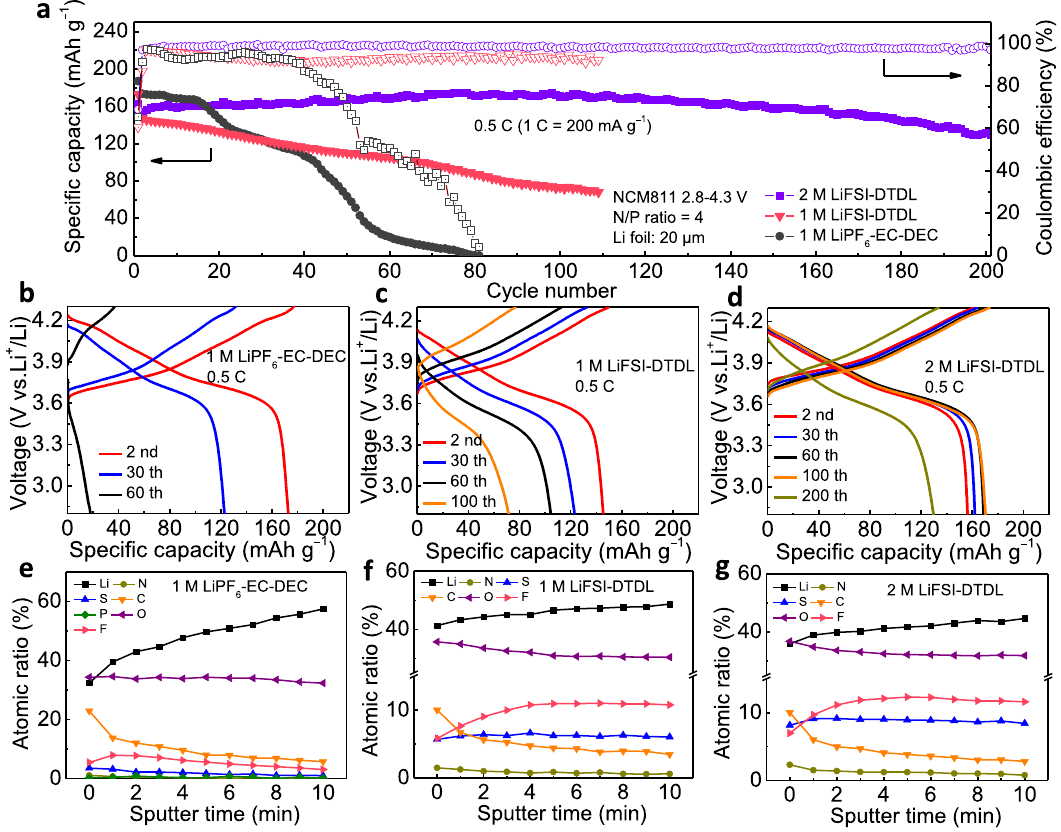
Fig. 4 Electrochemical performance and SEI compositions of Li|NCM811 full cells. a Cycling performance of Li|NCM811 full cells at 0.5 C after the fi rst formation cycle at 0.1 C in each electrolyte. Charge/discharge pro fi les of Li|NCM811 full cells at different cycles in 1 M LiPF 6 -EC-DEC ( b ), 1 M LiFSI-DTDL ( c ) and 2 M LiFSI-DTDL ( d ) electrolytes. Quanti fi ed atomic ratios of SEI at different sputter time in Li|NCM811 full cells after 30 cycles at 0.5 C with 1 M LiPF 6 -EC-DEC ( e ), 1 M LiFSI-DTDL ( f ) and 2 M LiFSI-DTDL ( g )